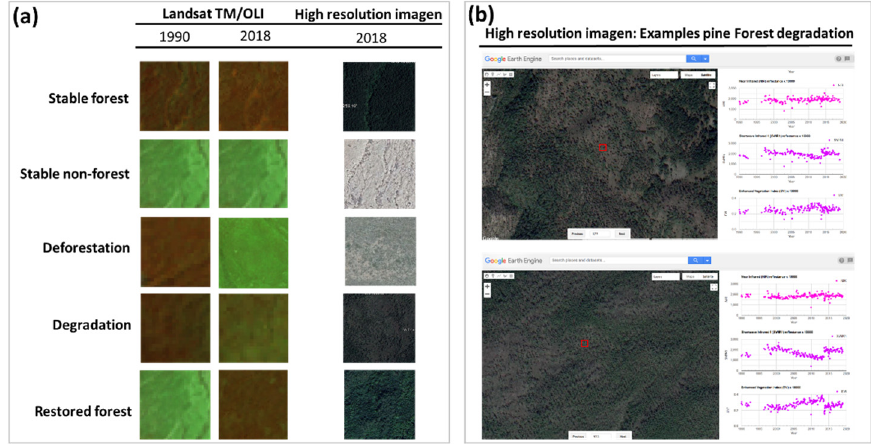
Figure 6. Example of the image composites of different land cover dynamic change classes for pine forests of the Dominican Republic. ( a ) NIR - SWIR1 - RED Landsat Thematic Mapper (TM) and Operational Land Imager (OLI) versus a high-resolution image; ( b ) example of degraded pine forests observed using Google Earth Engine (GEE).